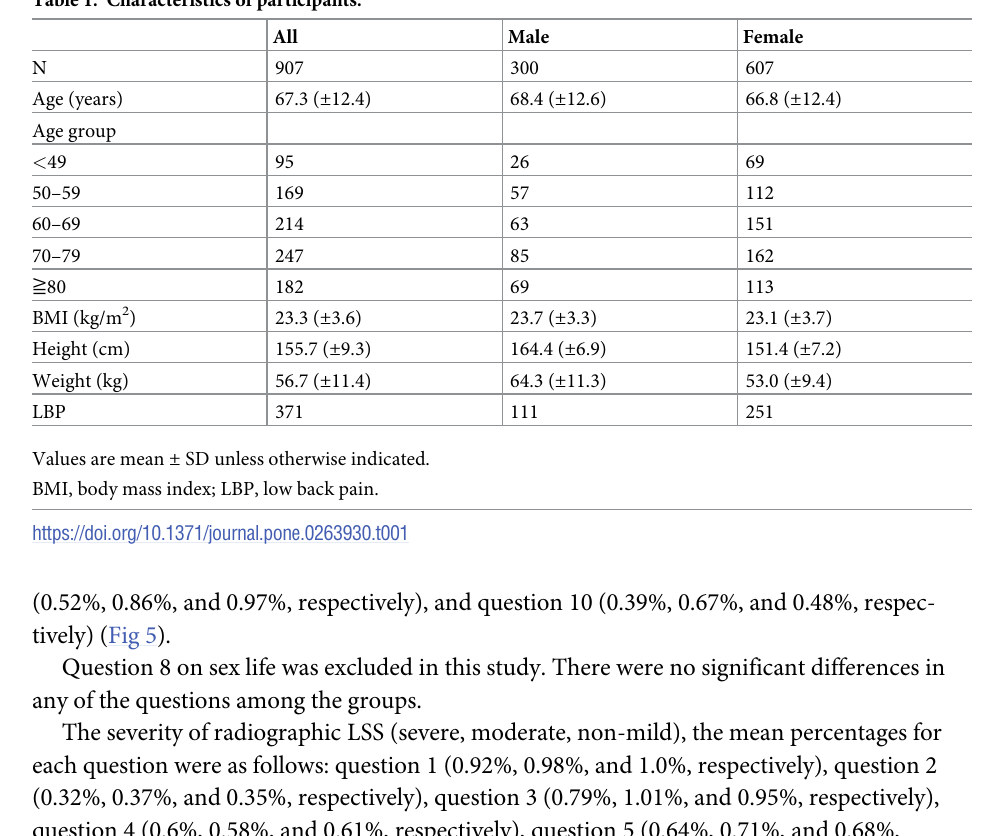
Table 1. Characteristics of